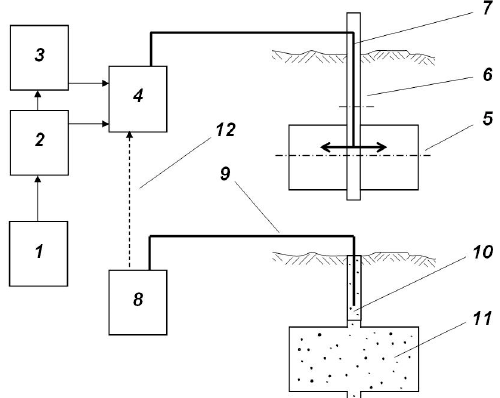
Figure 8. Slaughter intra-soil dispersed waste recycling. Slaughterhouse waste source, 1; shredder, 2; water source, 3; mixer, 4; intra-soil milling device, 5; drive, 6; slaughterhouse waste pulp channel, 7; disinfectant source, 8; disinfectant channel, 9; disinfected soil layer, 10; pulp mixed with soil, 11; hydraulic channel, 12.